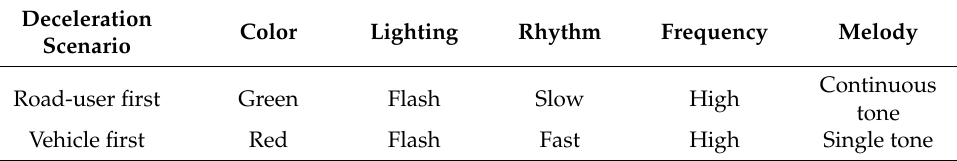
Table 9. Signal combination with the highest average of subjective cognitive assessment for decelera- tion scenario.